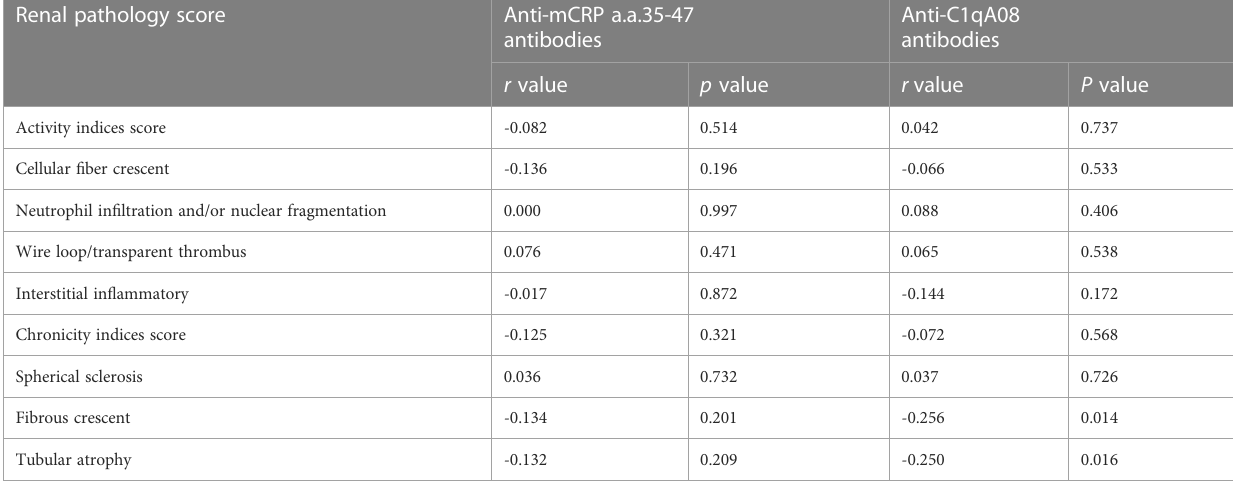
TABLE 3 Associations of anti-C1qA08 antibodies and anti-mCRP a.a.35-47 antibodies with renal pathology scores.